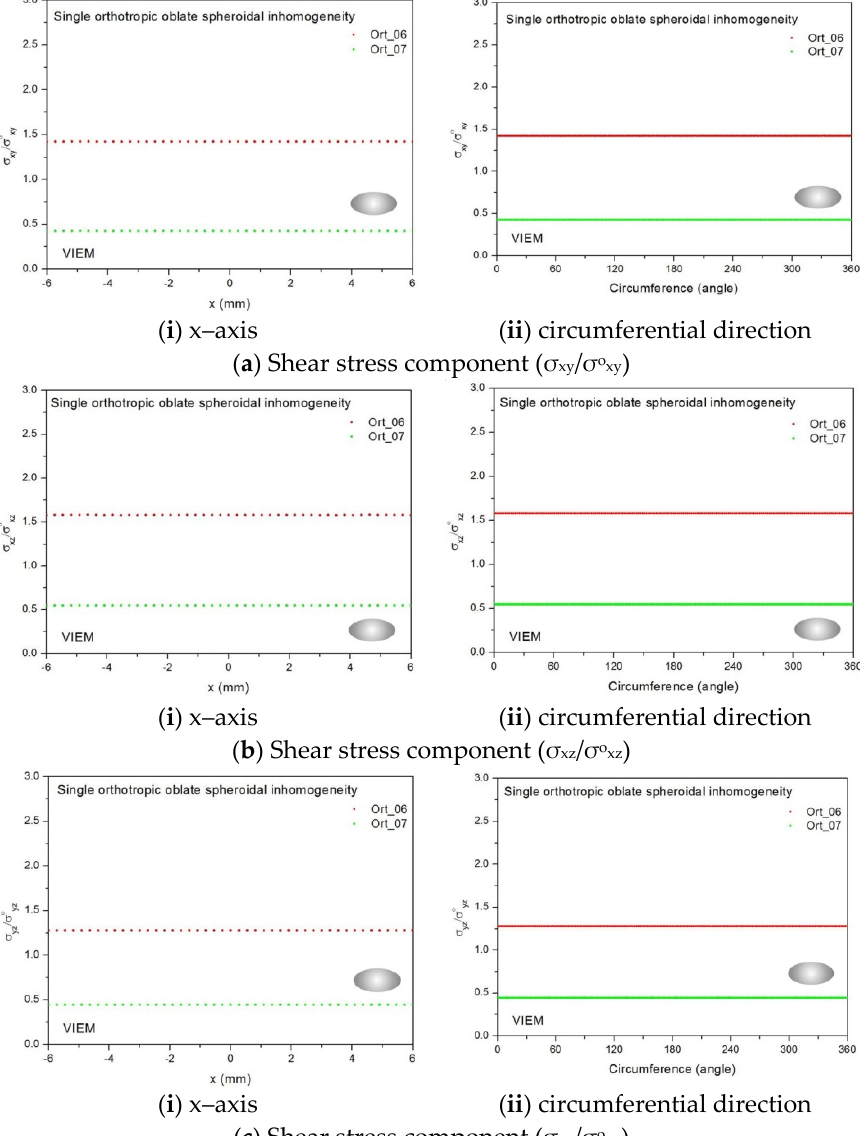
Figure 31. VIEM results for the normalized shear stress components ( a ) σ xy / σ oxy , ( b ) σ xz / σ oxz and ( c ) σ yz / σ oyz along ( i ) the x–axis inside and ( ii ) the circumferential direction of the orthotropic oblate spheroidal inclusions (Ort_06 and Ort_07) with b/a = c/a = 0.5 (a = 6 mm) under remote shear loading ( σ oxy , σ oxz and σ oyz ).